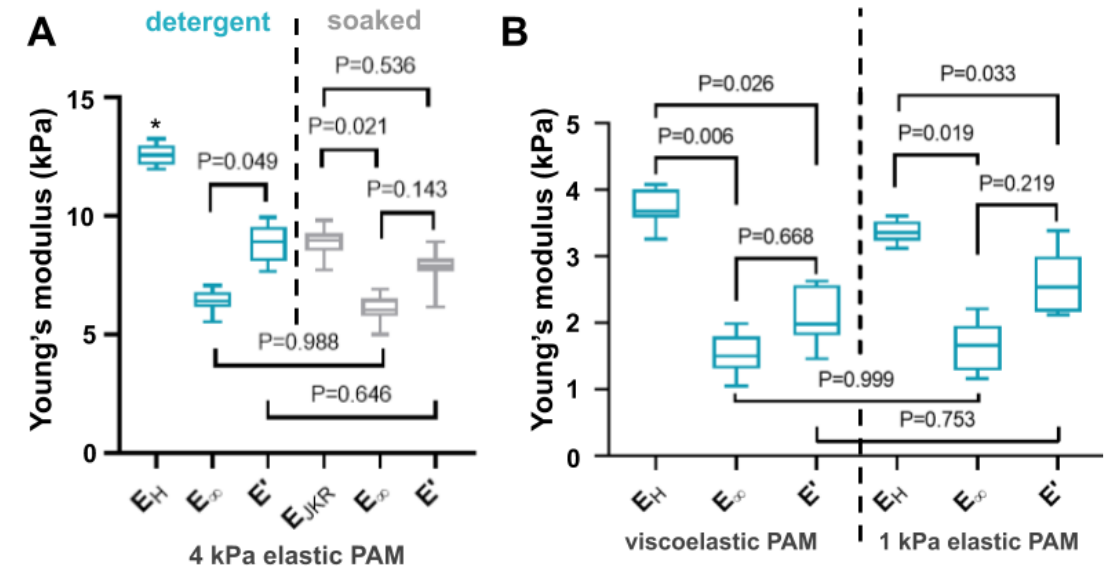
Figure 5. Comparison between the elastic modulus obtained from microindentation and the most relevant model for data fitting, and relaxation tests, using the GMM model. ( A ) Comparison between values calculated for hydrogels immersed in a detergent solution of ddH 2 O + 0.1% Extran (cyan) and only soaked with ddH 2 O and measured in air (grey). In the case of the microindentation test, the Hertz model was used to determine E H in immersed samples while the JKR (Johnson, Kendall and Roberts) model was preferred to calculate E JKR for soaked gels. In the case of relaxation tests, the 3rd order GMM model allowed the calculation of long-term elastic modulus E ∞ as well as the determination of E’ (ω) and E” (ω) for a given frequency range delimited by 10 − 2 - 10 1 Hz. In this graph, E’ ( ⍵ =1 Hz) is shown and noted E’. ( B ) Same comparison for the soft viscoelastic PAM and 1 kPa elastic PAM. Their apparent elastic moduli when submerged in detergent are very similar when using microindentation (see Table 1), but are much larger than expected (see text). Boxes are the interquartile range (Q1 – Q3) and bars extend to the maximum and minimum values. All the experimental data are presented as scatter plots in the Appendix C Figure C2, for more details. A one-way analysis of variance (ANOVA) analysis with Tukey correction was employed for multiple comparisons. It was considered significant statistically with p < 0.05, * stands for p < 0.01.